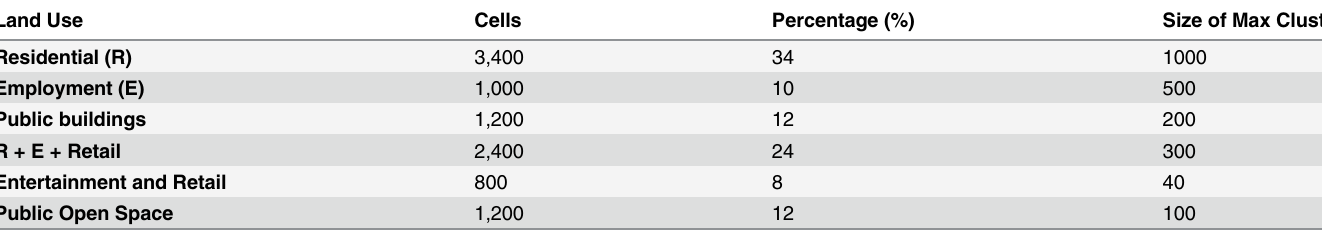
Table 1. Land uses distribution for the spatial environment used in our